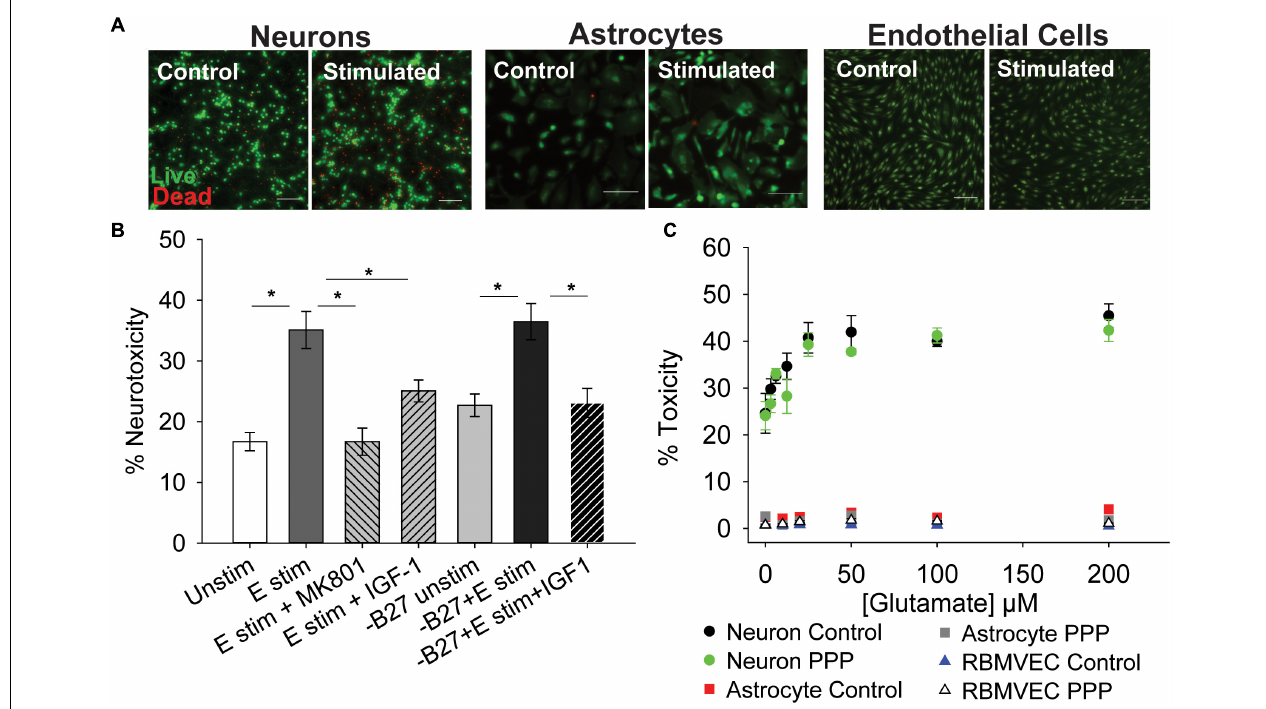
FIGURE 1 | IGF-1 protects against excitotoxicity in glutamate-sensitive neurons. (A) Representative images of neurons (left two panels), astrocytes (middle two panels), and rat brain microvascular endothelial cells (right two panels) stained with live (green)/Dead (red) viability/cytotoxicity indicator dyes 24 h after stimulation with control or 100 µ M glutamate, as indicated. Scale bar represents 100 µ m. (B) Average toxicity in neurons 24 h after treatment ( n = 8 wells/group). A one-way ANOVA with post hoc Bonferroni was used for statistical comparisons; *indicates significant difference between the delineated bars. (C) Average toxicity of cells 24 h after acute treatment with both 0.5 µ M PPP and increasing concentrations of glutamate ( n = 4–8 wells/group). A two-way ANOVA was employed with glutamate concentrations and PPP-treatment serving as factors. No significant differences were observed. Graph color code: black circles = vehicle-treated neurons; green circles = PPP-treated neurons; red boxes = vehicle-treated astrocytes; dark gray boxes = PPP-treated astrocytes; blue triangles = vehicle-treated rat brain microvascular endothelial cells (RBMVEC); and light gray triangles = PPP-treated RBMVEC. All data are presented as mean ±